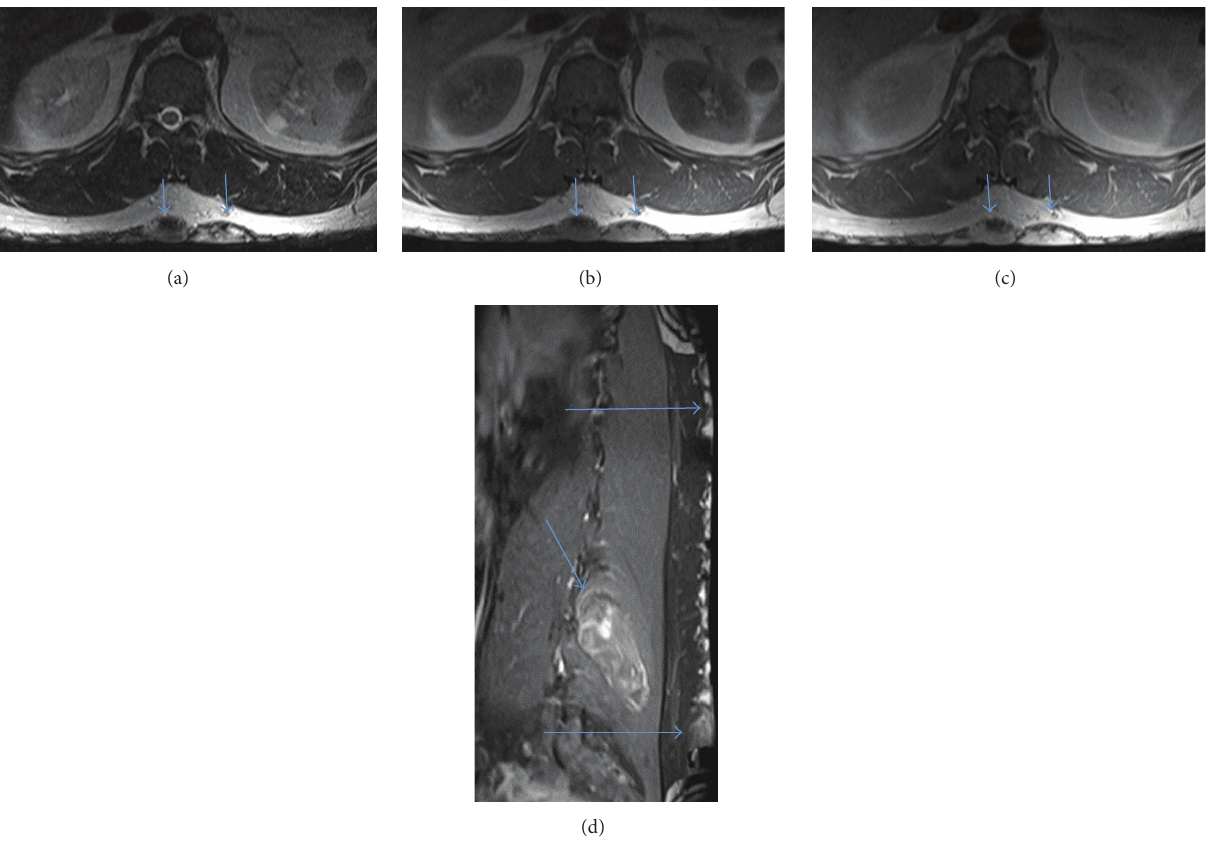
Figure 4: (a) Axial T2 shows neurofibromas on the skin surface (arrows). (b) Axial T1 shows neurofibromas on the skin surface (arrows). (c) Axial T1 + contrast shows enhancing neurofibromas on the skin surface (arrows). (d) Sagittal T1 FS + contrast shows heterogeneous enhancing right erector spinae/multifidus muscle neurofibroma (short big arrow) and enhancing neurofibromas on the skin surface (long thin arrows).